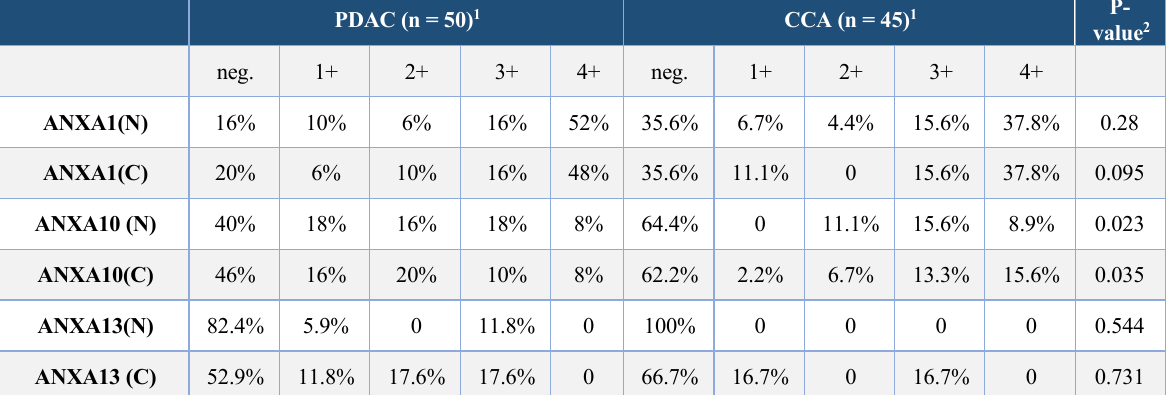
Table 3. IHC results and comparison in the cases of CCA and PDA (N=Nuclear, C=Cytoplasmic)